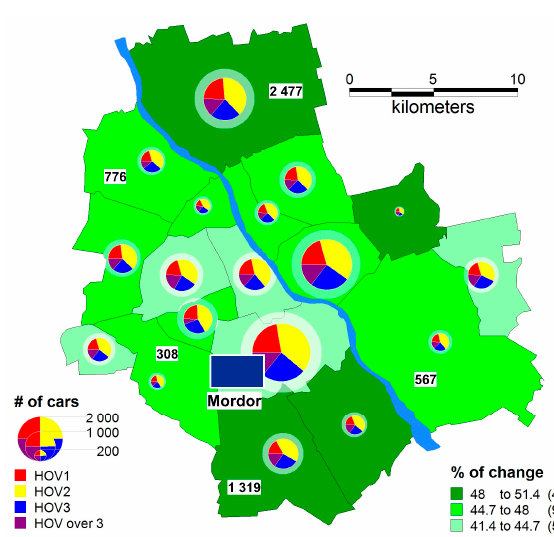
Figure 10. The number of cars (the number of passengers): a pie chart and the percentage change in the number of cars compared to the referential variation—a reference auction.